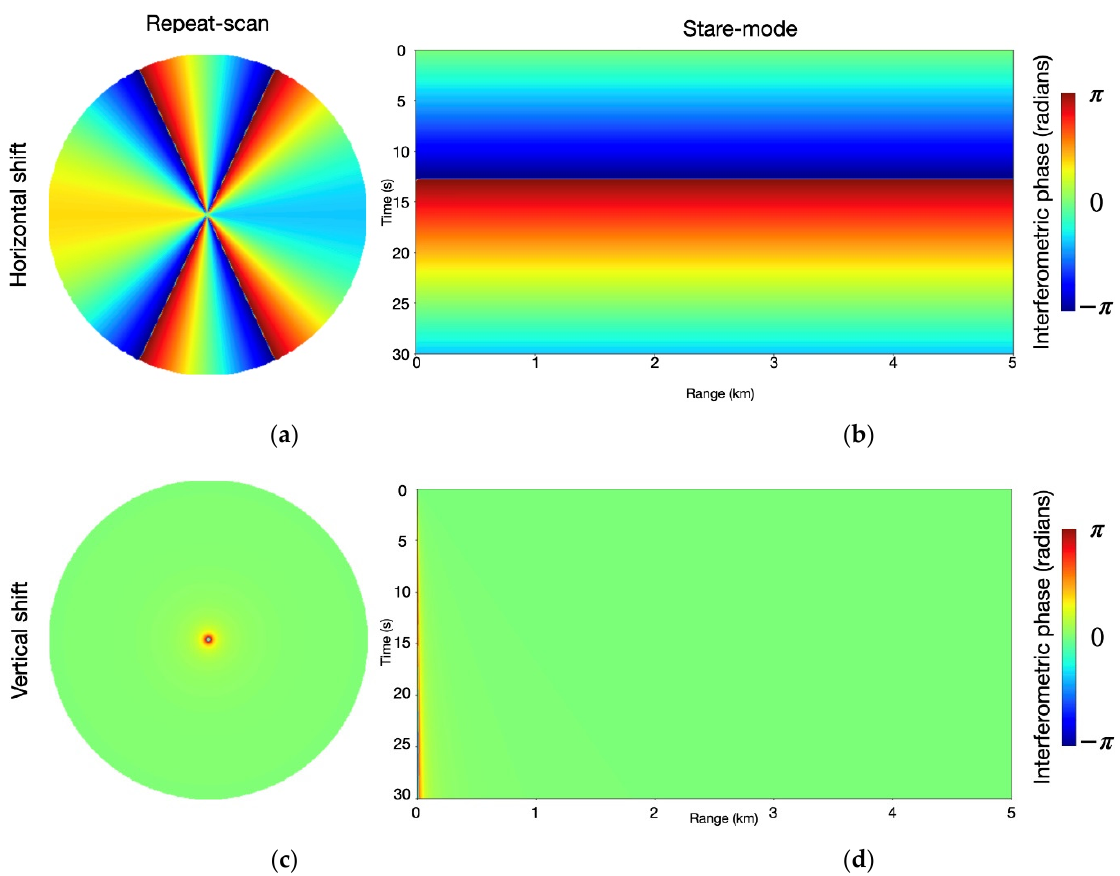
Figure 10. ( a , b ) Modeled signals from a tilted/horizontally shifted sensor (1 cm eastward shift). ( c , d ) modeled signals of a 5 cm vertical antenna displacement.